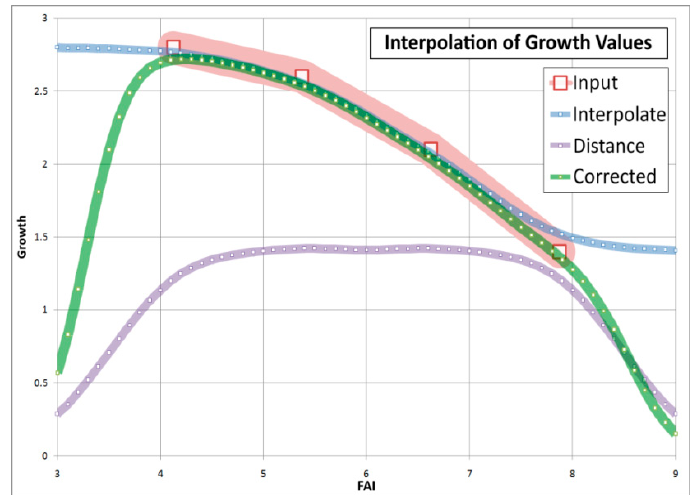
Figure 8. Interpolation of approximated growth rate of sessile oak with distance kernels, for a single site descriptor, climate, characterized by FAI values. Explanations in the text and in Appendix A.4 (Czimber, original).